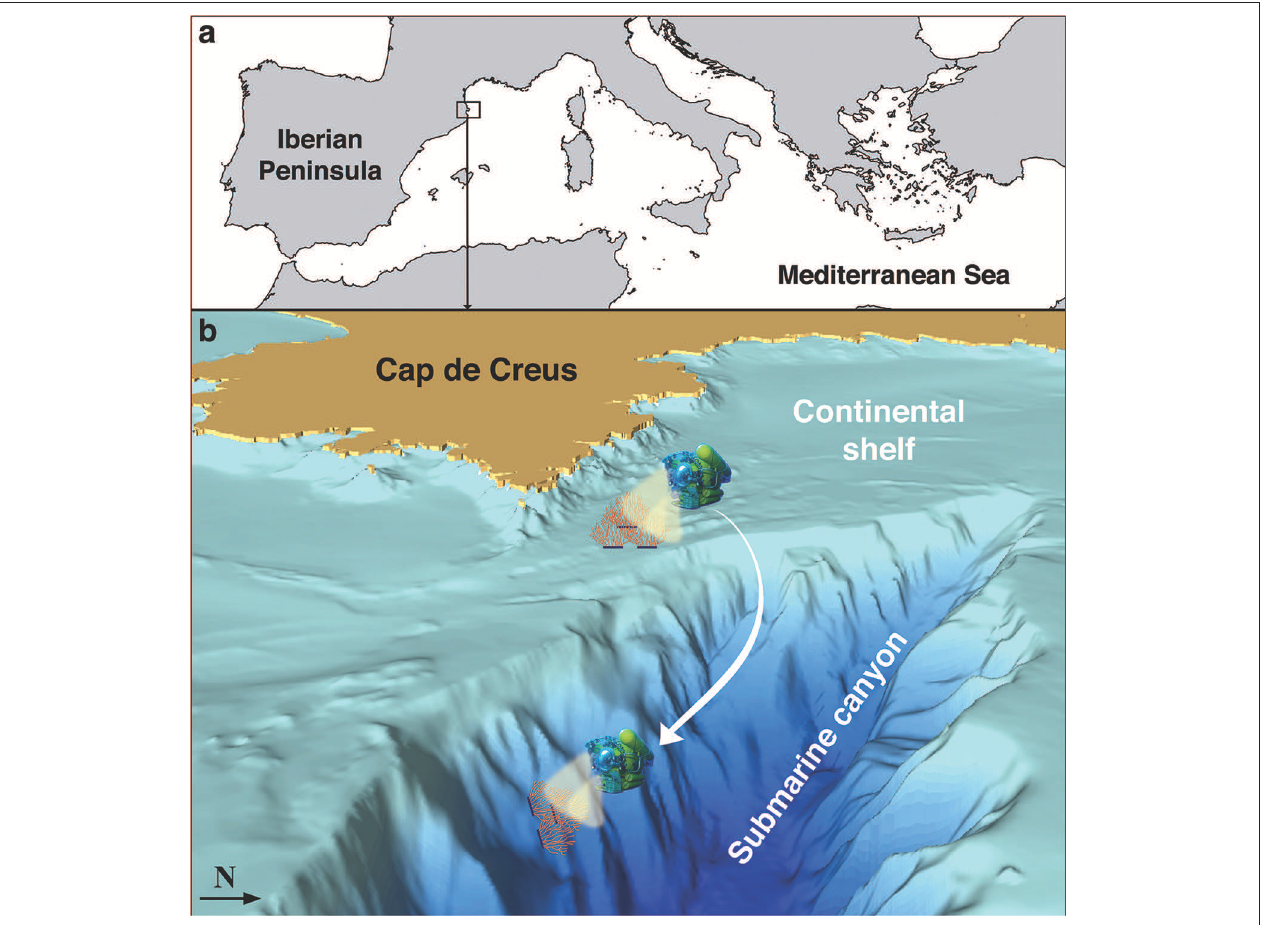
FIGURE 2 | (a) Location of Cap de Creus marine area, at the end of the Gulf of Lions in NW Mediterranean. (b) Recreation of the path performed by the manned submersible in Cap de Creus during the virtual dive, starting on the continental shelf and moving towards 400m depth by the southern flank of the submarine